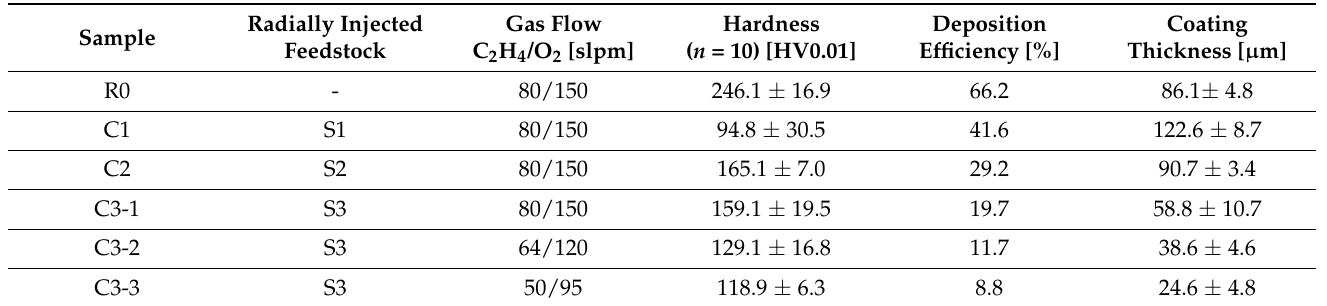
Table 4. Characteristics of the samples coated under different gas flow conditions and with different suspensions radially